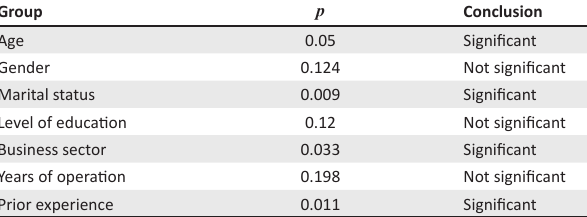
TABLE 5: Showing results of analysis of variance